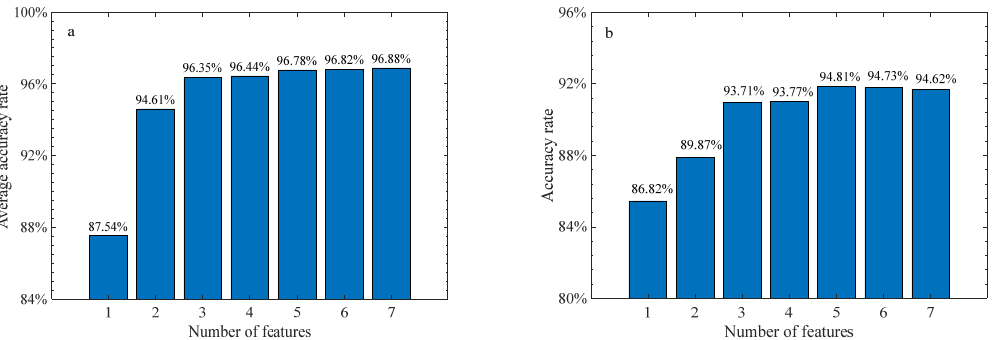
Figure 7. The recognition AR with respect to number of features. ( a ) is the averaged result for every two species with 5-fold cross validation and ( b ) is for the 11 species with 10-fold cross validation.